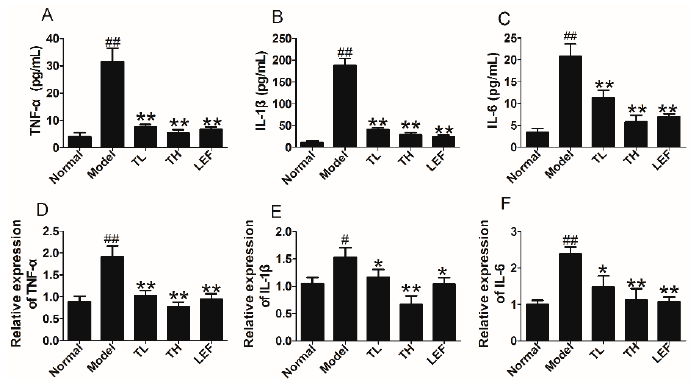
Figure 7. Effects of TP on proinflammatory cytokines expression in CIA rats. ( A – C ) TNF- α , IL-1 β and IL-6 levels in serum of CIA rats after treatment with TP; and ( D – F ) TNF- α , IL-1 β and IL-6 mRNA levels in ankle joints of CIA rats after treatment with TP. Data are represented as the mean ± SD ( n = 7), # p < 0.05, ## p < 0.01 in comparison with the normal group; * p < 0.05, ** p < 0.01, comparison with the model group.